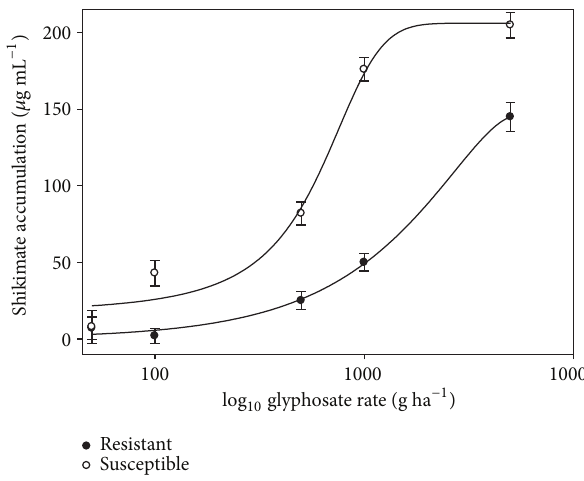
Figure 2: Shikimate accumulation by glyphosate-resistant and glyphosate-susceptible Palmer amaranth 5d after glyphosate appli- cation. Data are pooled over two experiments. Regression expres- sions are resistant biotype, 𝑌 = 0.000001𝑥 2 +0.01𝑥−0.36 , 𝑟 2 = 0.99 ; susceptible biotype, 𝑌 = 145/(1 + 𝑒 −((𝑥−1246)/406) ) , 𝑟 2 = 0.99